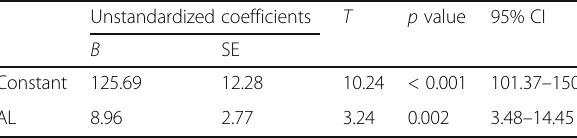
Table 2 Simple linear regression to evaluate the association of height and arc